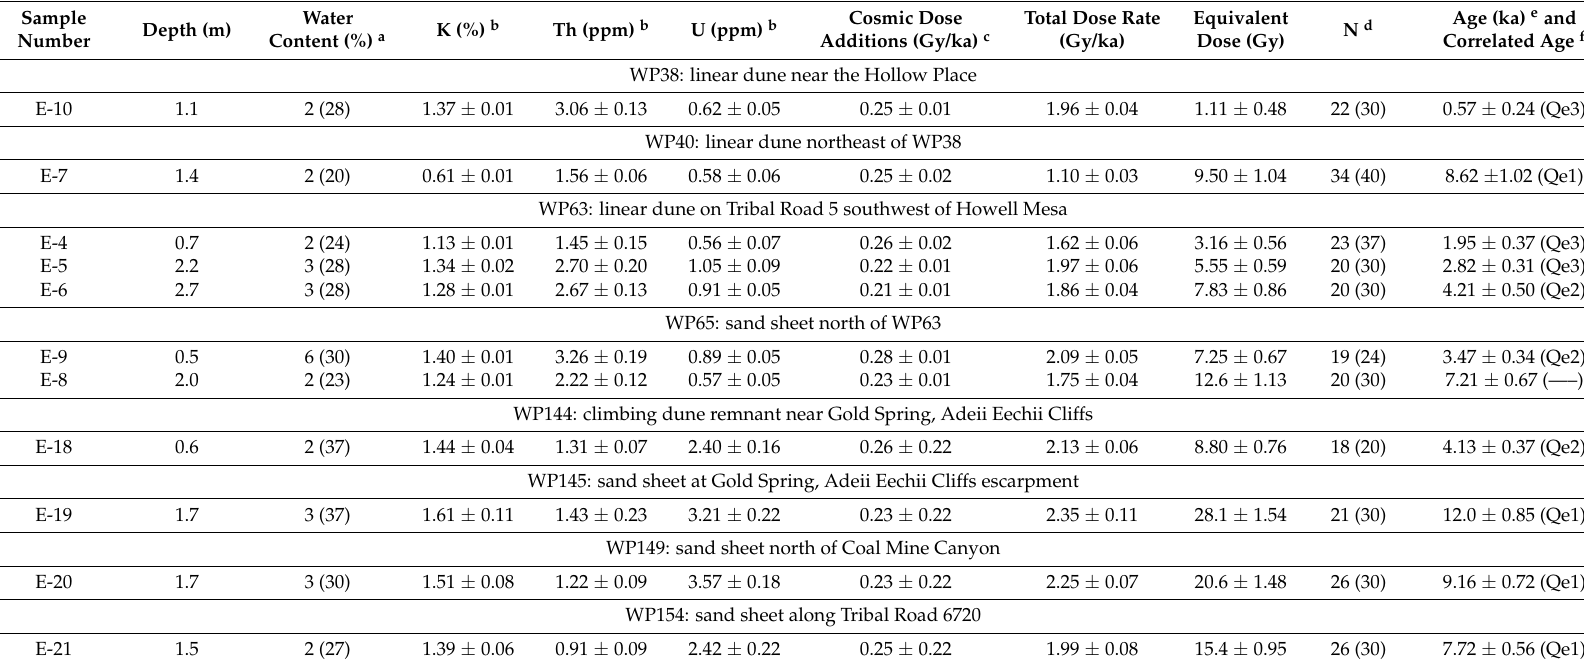
Table 5. Optical ages for eolian sand sedimentary deposits from sites on the Moenkopi Plateau, northeastern Arizona. Equivalent dose and OSL age determined using single aliquot regeneration (SAR) protocols under blue light excitation